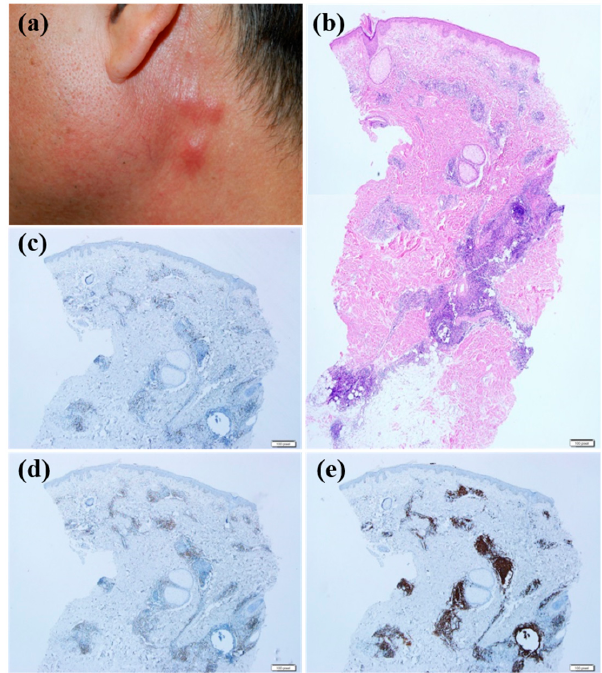
Figure 4. The clinicopathological features of trauma-associated cutaneous lymphoid hyperplasia; ( a ) multiple erythematous nodules were observed after injection-related trauma. ( b ) Biopsy specimen of the nodule reveals lymphocytic infiltration into deep dermis and subcutis (hematoxylin-eosin stain; magnification: ×20). Only small portions of lymphocytes showed positive reactivity for CD4 ( c ) and CD8 ( d ), while most lymphocytes showed positivity for CD20 ( e ) (×40).